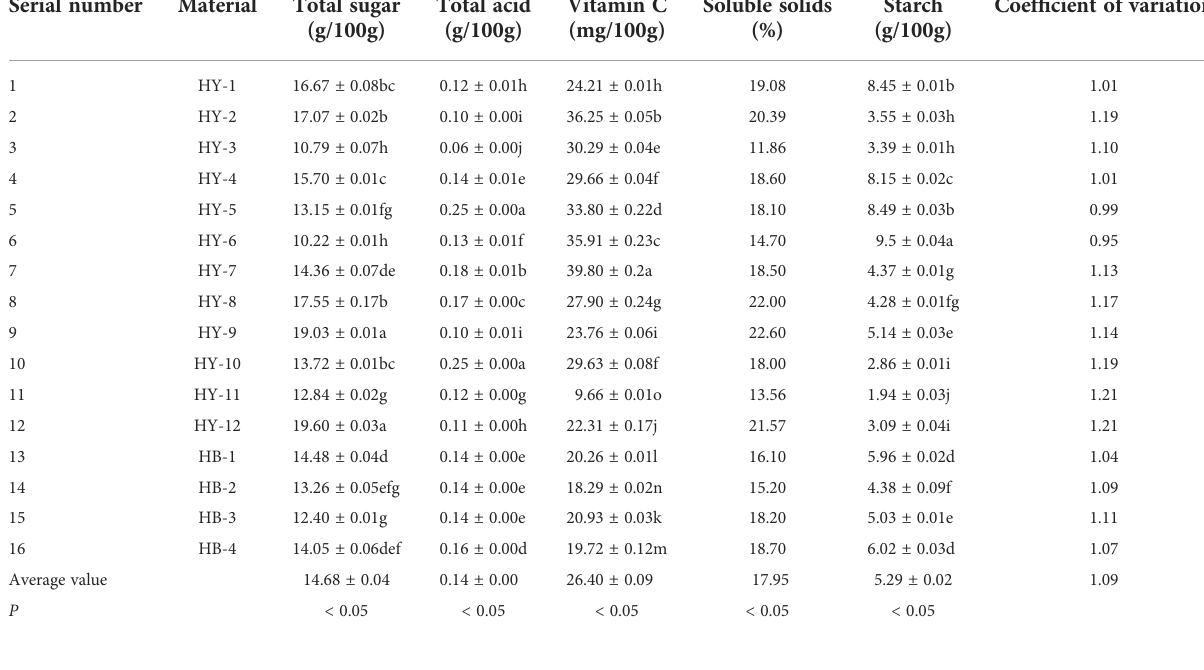
TABLE 3 The content of main chemical components in the pulp of different genotypes of A. trifoliata fruit. Serial